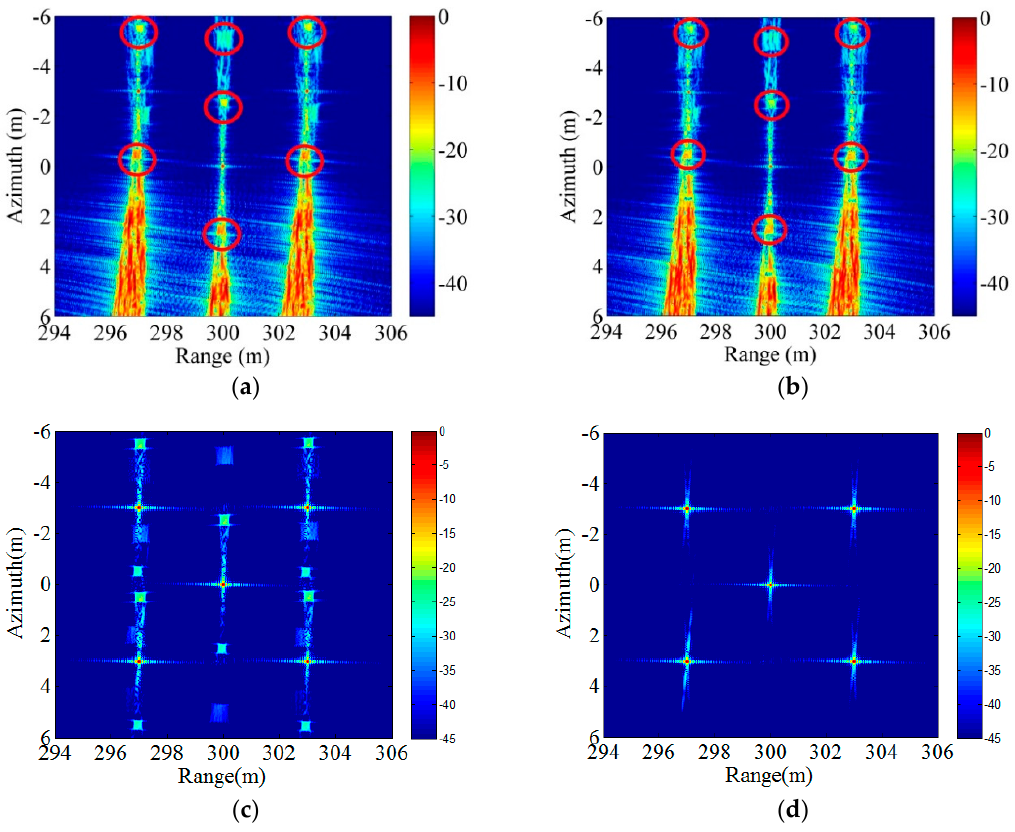
Figure 6. The imaging results. ( a ) No correction; ( b ) Only pitch angle correction; ( c ) Only yaw angle correction; ( d ) Both pitch angle and yaw angle correction. Table 2. The parameters of imaging quality.